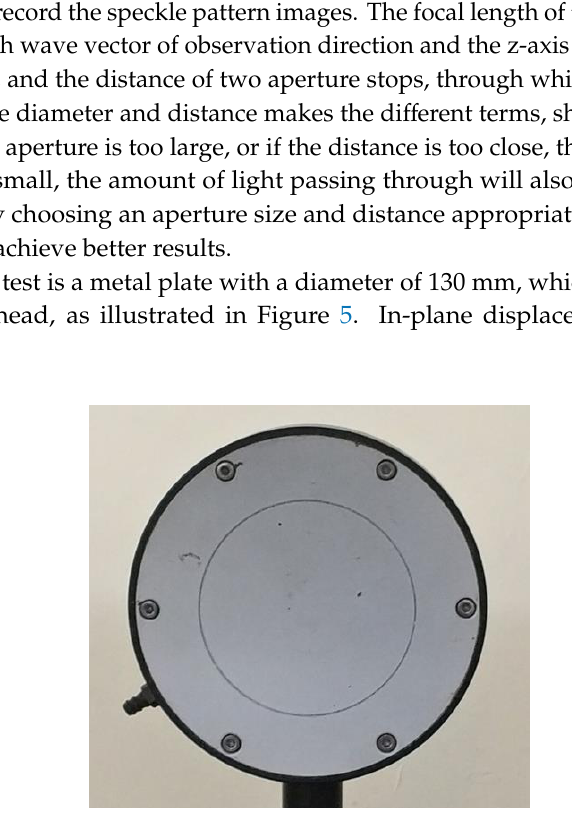
Figure 5. Object capable of rotating in-plane by a micro-head.